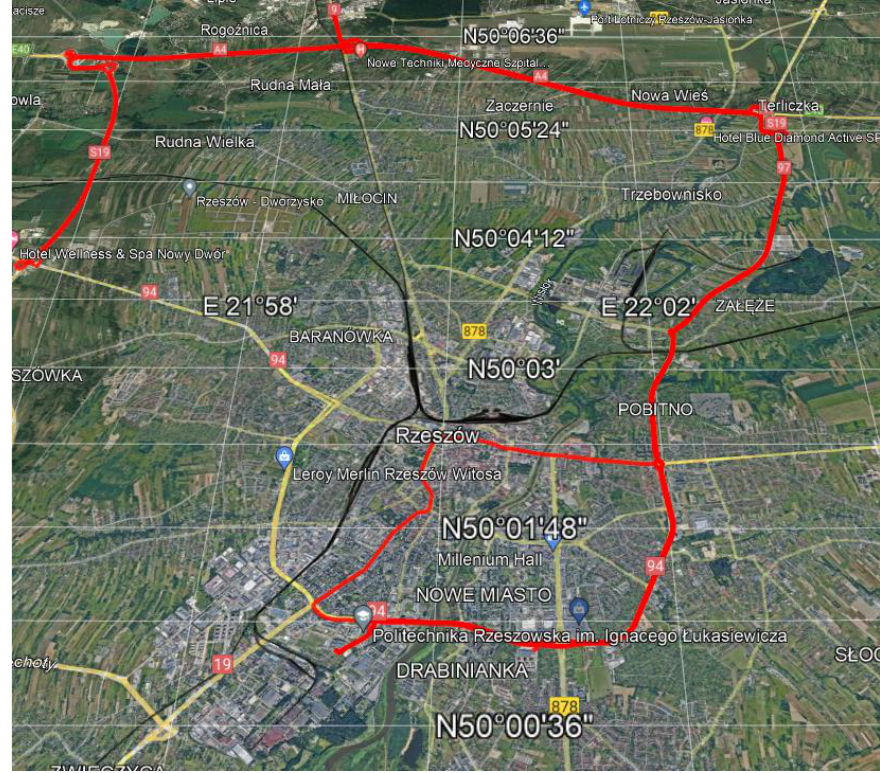
Figure 3. Route tested of an LPG vehicle.